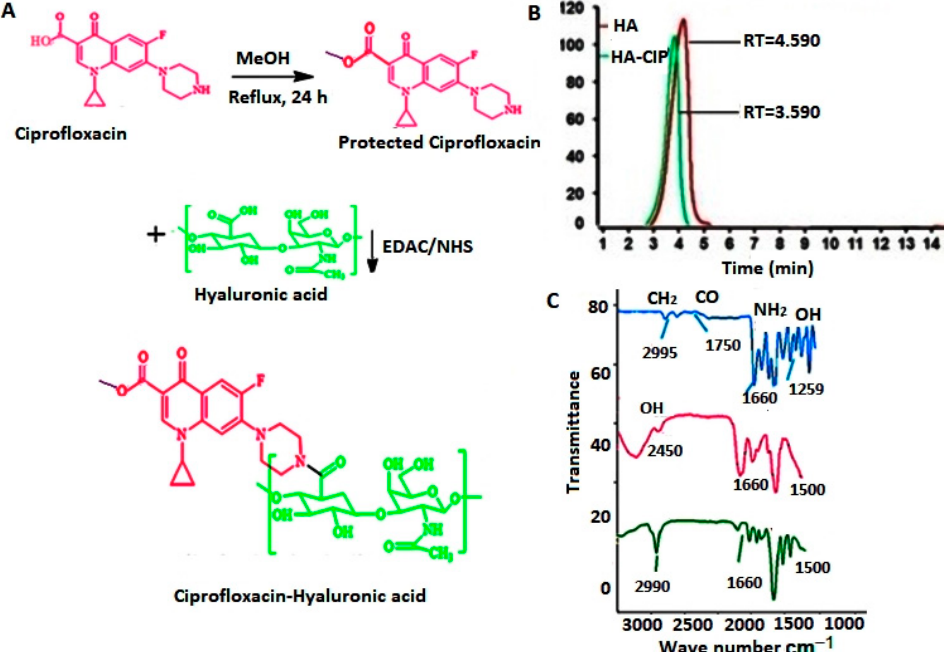
Figure 1. ( A ) Hyaluronic acid conjugated with ciprofloxacin to form Hyaluronic acid-Ciprofloxacin (HA-CIP) conjugate, ( B ) Size exclusion chromatography of HA and HA-CIP conjugate. The decrease in the retention time (RT) of the conjugate peak as compared to HA confirmed the synthesis of the conjugate. ( C ) FTIR spectra of CIP ( a ), HA ( b ) and HA-CIP ( c ).